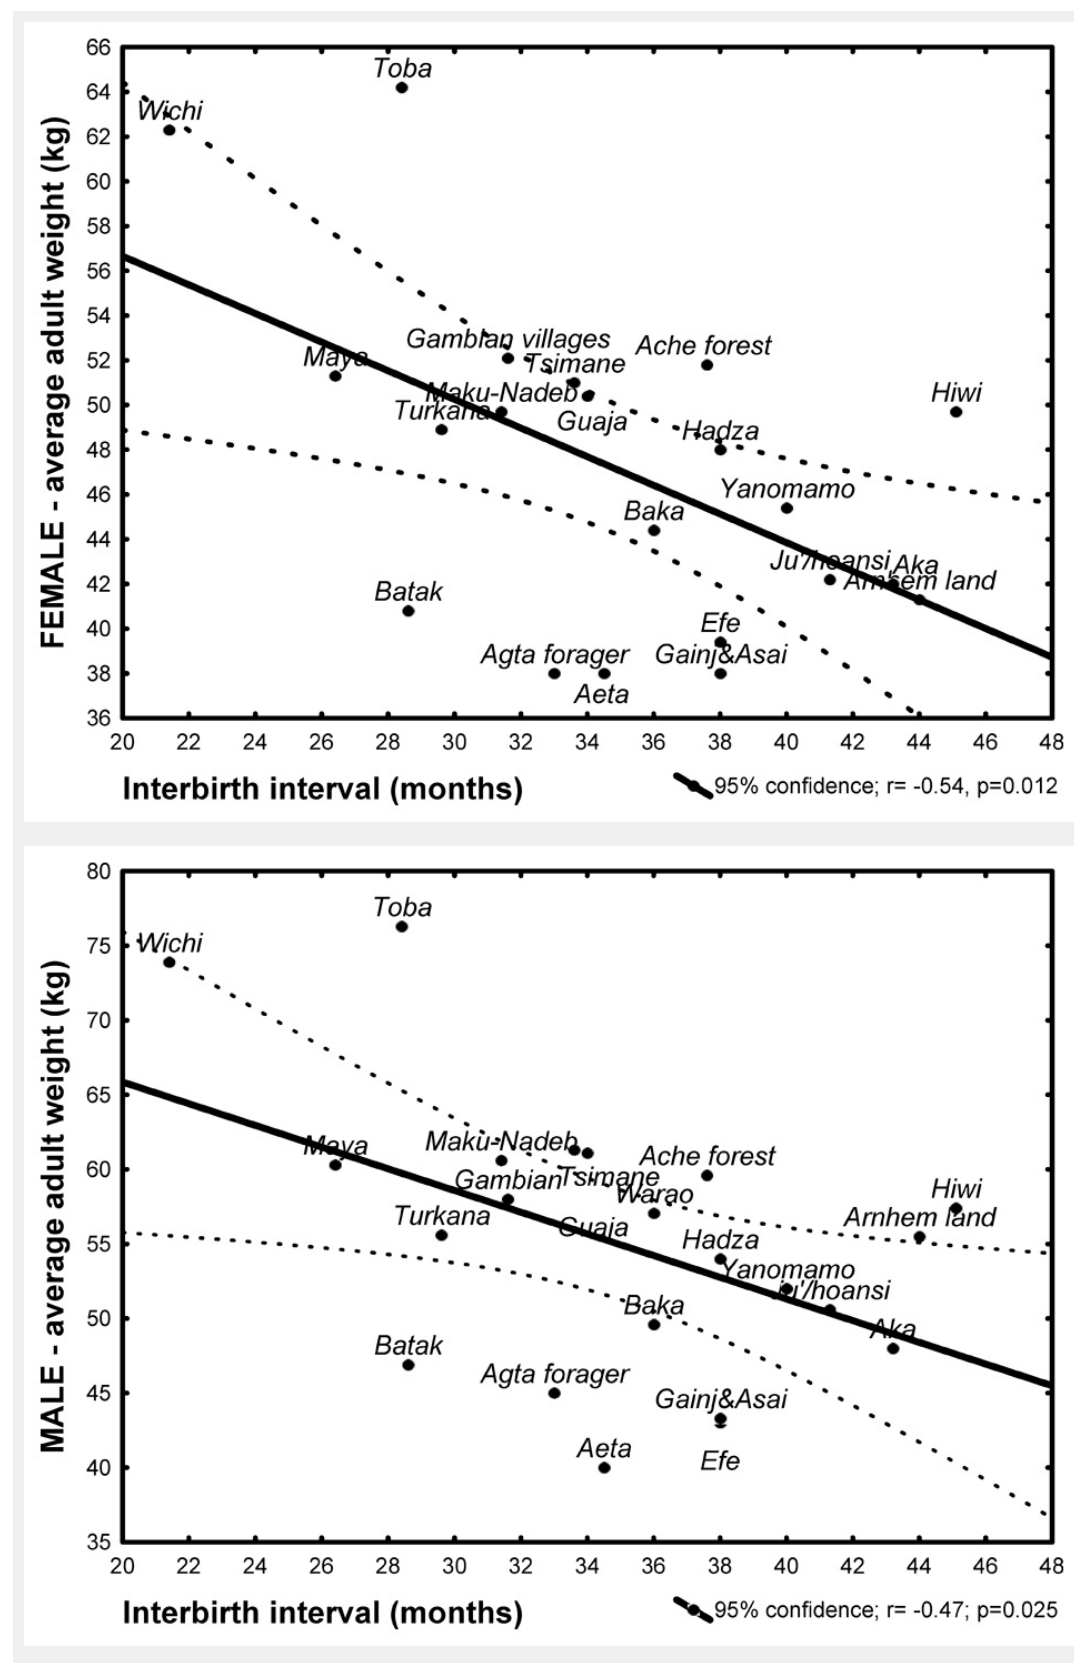
Figure 2 Interbirth interval (IBI) and adult size. The regression line and the 95% confidence limits for the adult body-weight in women (a) and men (b) as a function of IBI in traditional